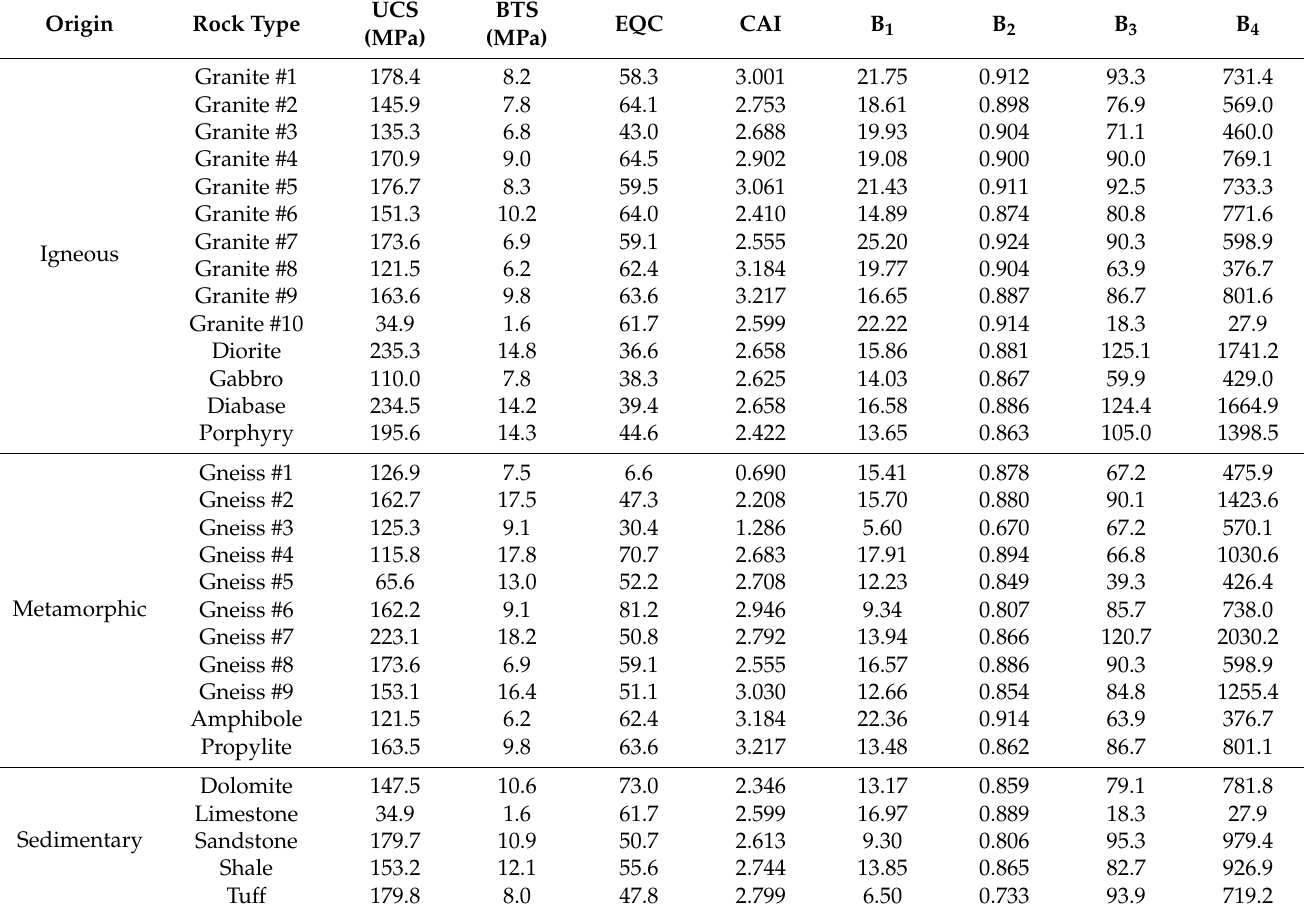
Table 4. Cerchar abrasivity index (CAI) values and mechanical properties of Korean rock